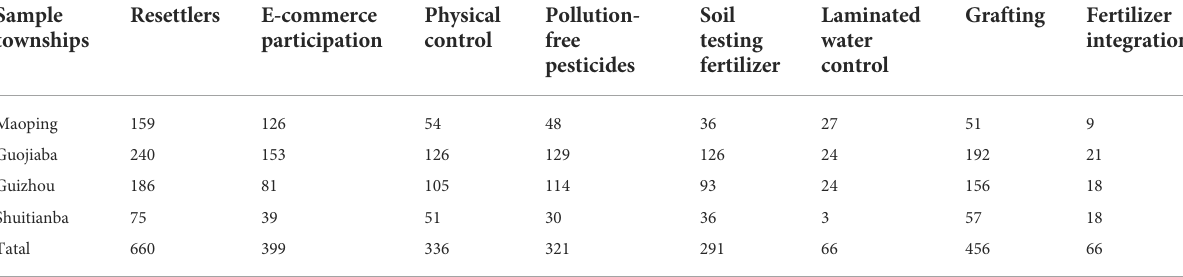
TABLE 1 Number of resettled households ’ adoption of various green agricultural